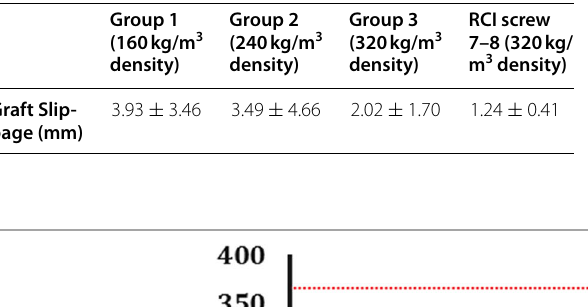
Table 3 The means, standard deviations, and range of graft slippage results for all test groups